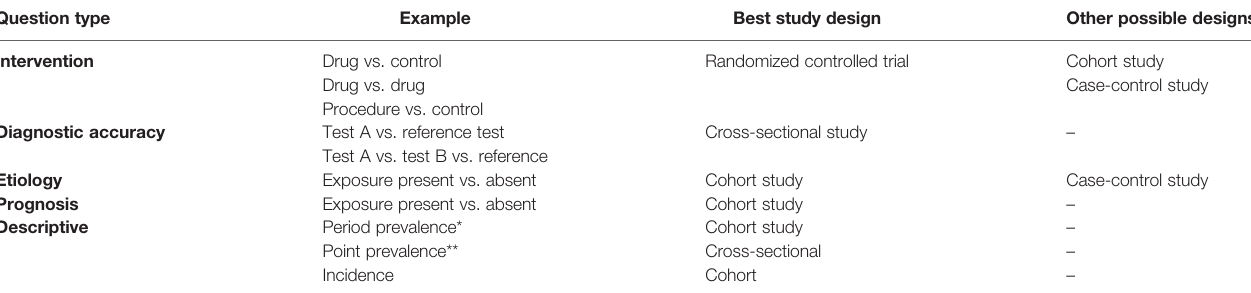
TABLE 1 | Appropriate study design for addressing different clinical